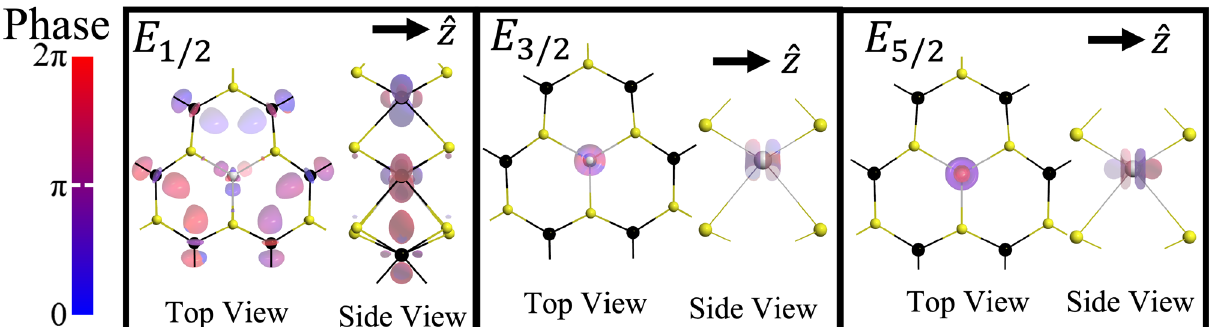
8 1 super cell of WS 2 × ×